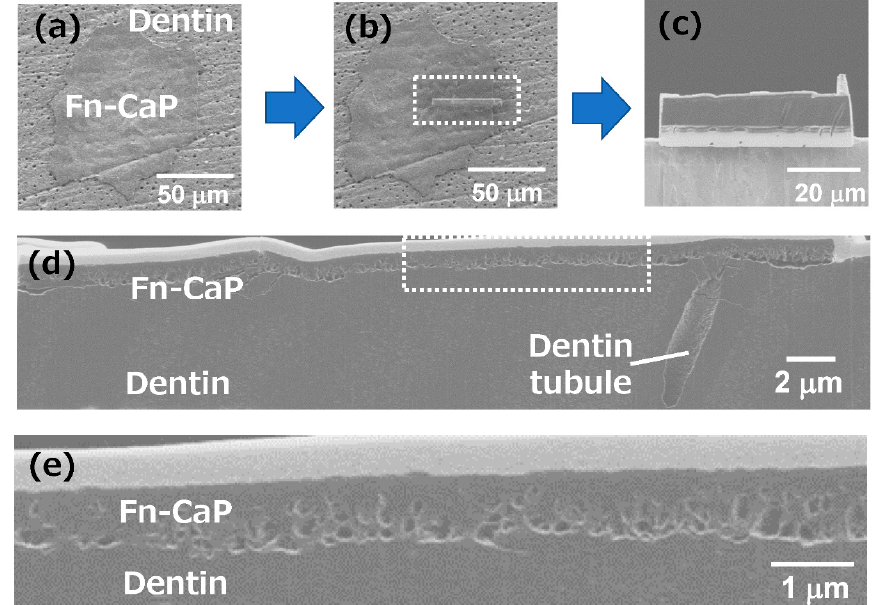
Figure 7. ( a – c ) SEM images of the dentin substrate with the Fn-CaP microchip, ( a ) before, ( b ) during, and ( c ) after the focused ion beam (FIB) processing. A part of the area surrounded by the white dotted line in ( b ) was sliced with a FIB. The sliced part was taken out for cross-sectional observation, as shown in ( c ). (d) The cross-sectional SEM image of the Fn-CaP microchip on the dentin substrate. ( e ) High-magnification SEM image of the area surrounded by the white dotted line in ( d ).